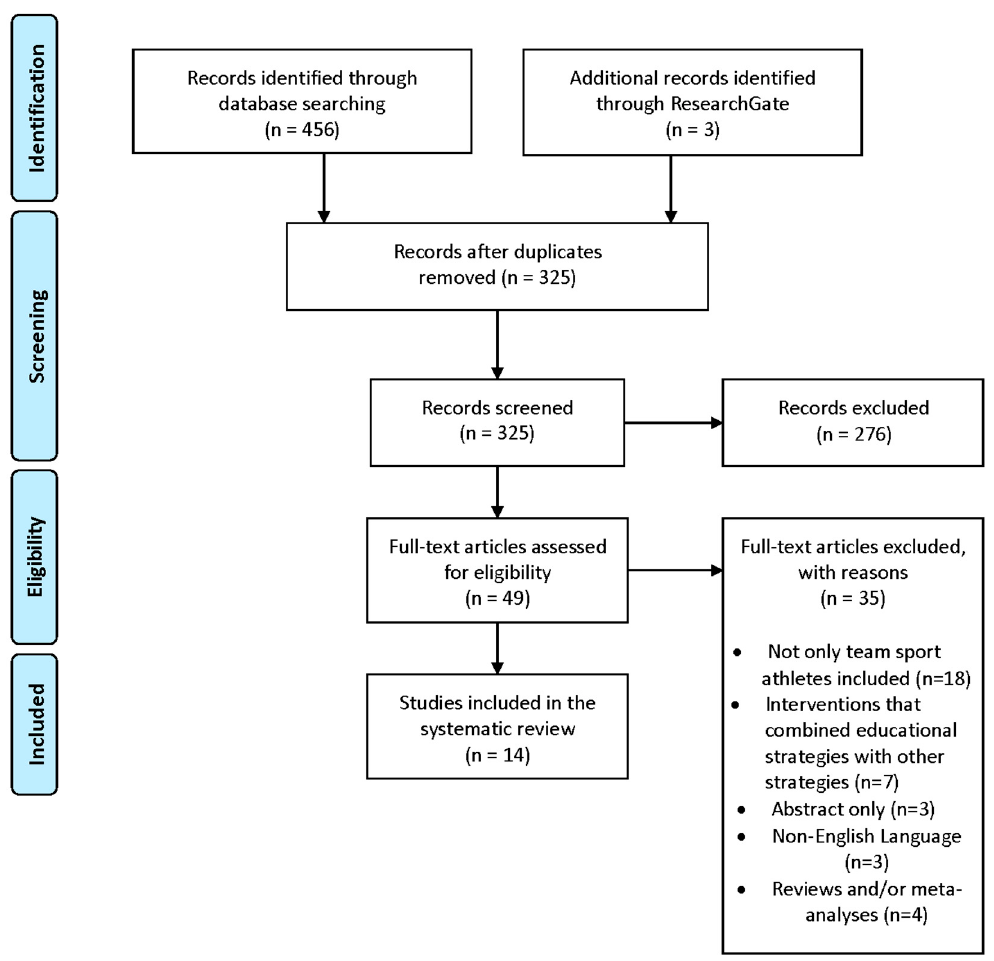
Figure 1. Flow diagram of the study retrieval process.